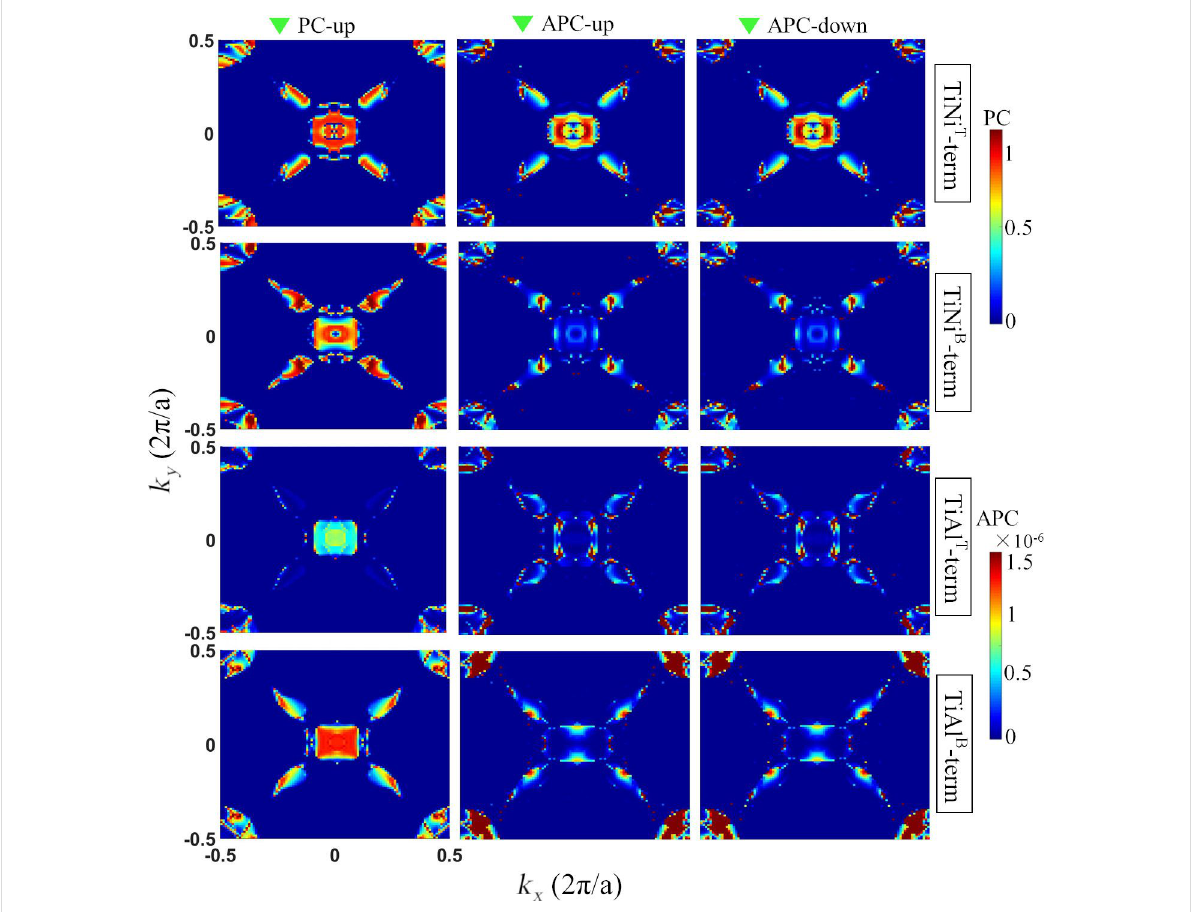
Figure 5: The k // -resolved transmission coefficients at the Fermi level of the Ti 2 NiAl/Ag/Ti 2 NiAl CPP-SV with different atomic terminated interfaces.